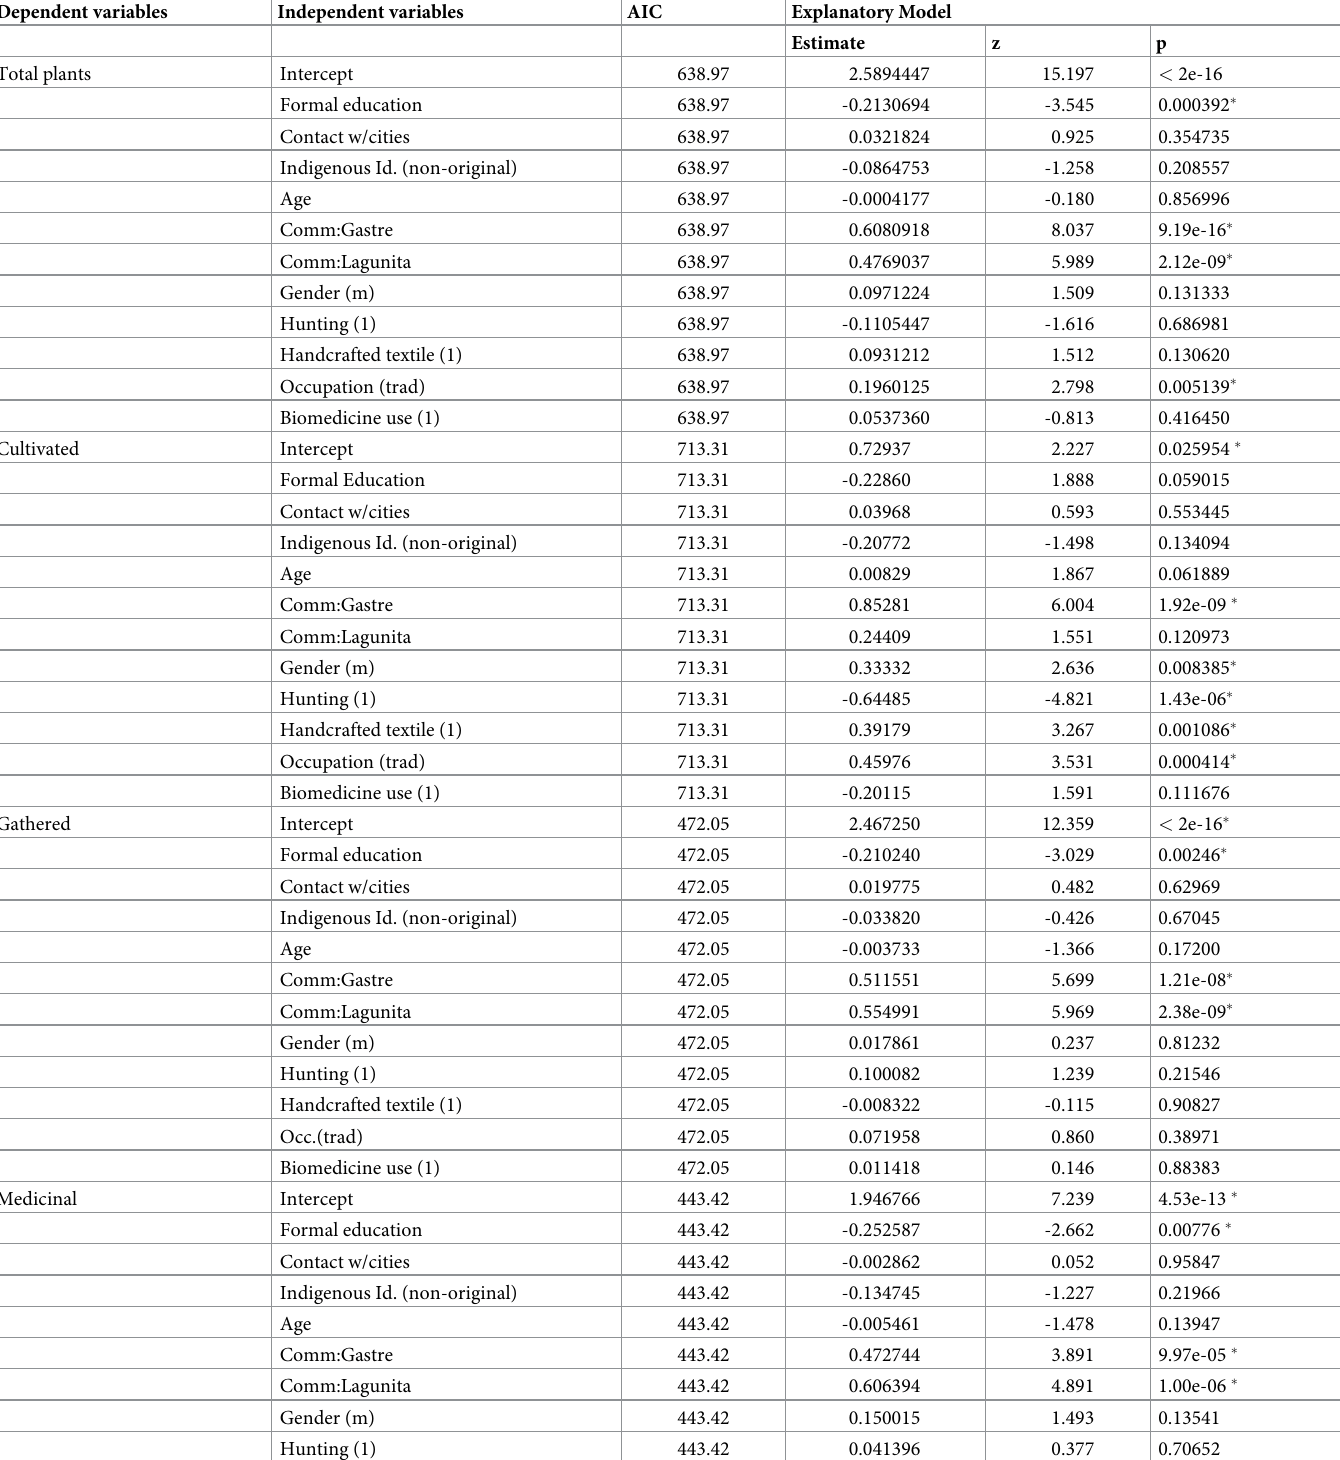
Table 2. More explanatory generalized linear model between sociocultural variables and knowledge of plants, AIC value, estimated regression parameters, z values and p values 1